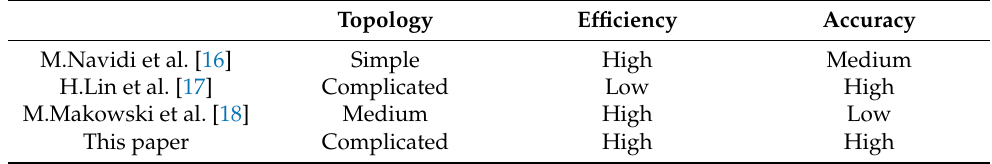
Table 1. Comparison with existing